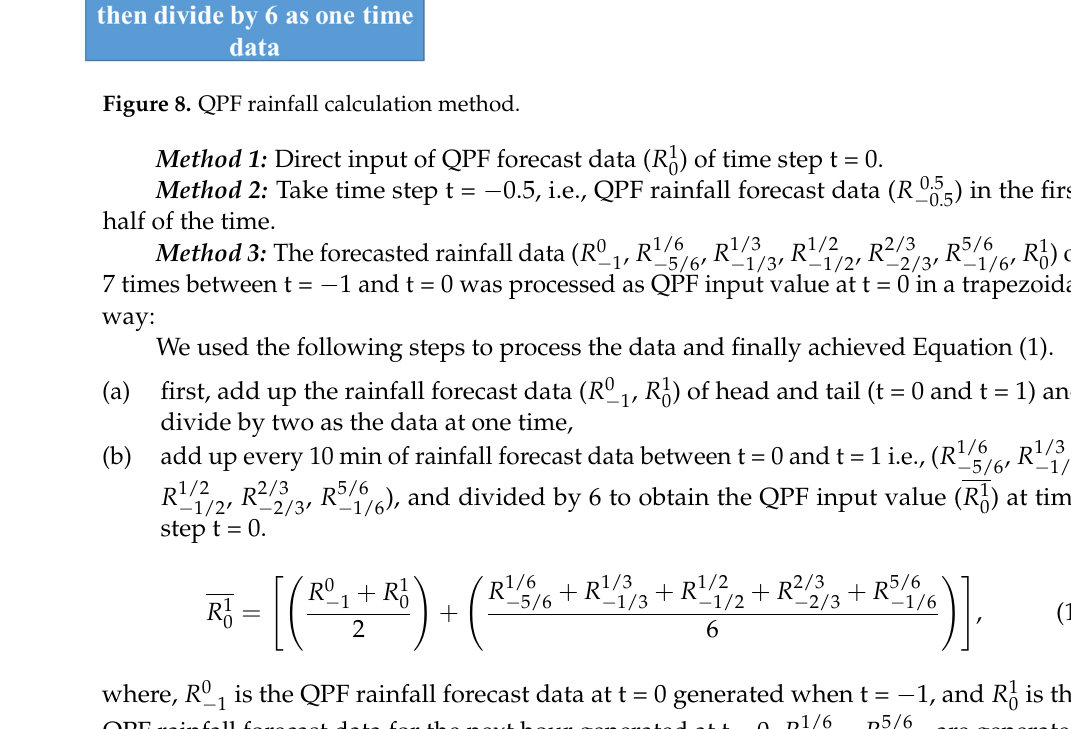
Figure 9. Physical real-time correction, a three-step approach, represented numbers 1 to 3 in red colour.